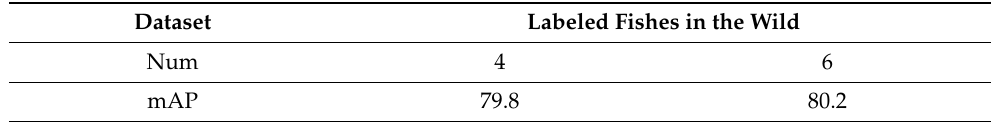
Table 3. Detection results of different number of prediction